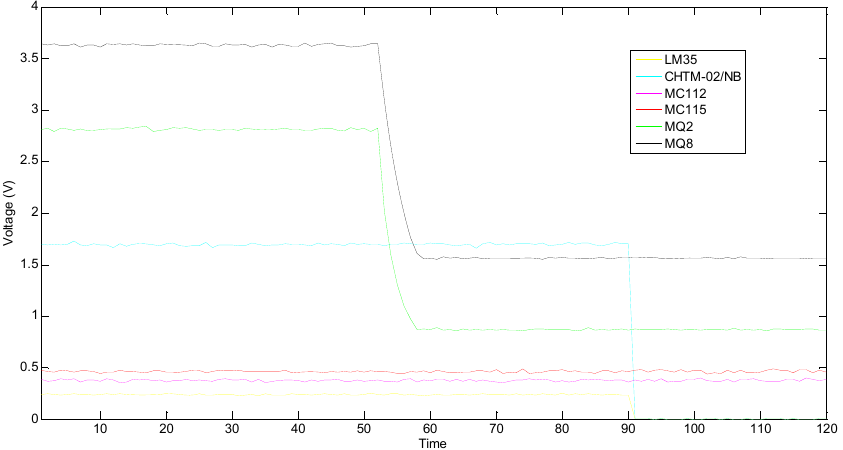
Figure 14. Static outputs when more sensitive units are